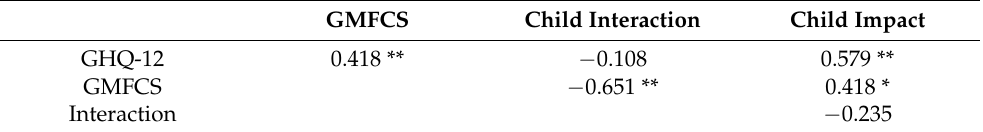
Table 5. Pearson correlations between GHQ-12, GMFCS, interaction, and impact scores. GMFCS Child Interaction Child Impact